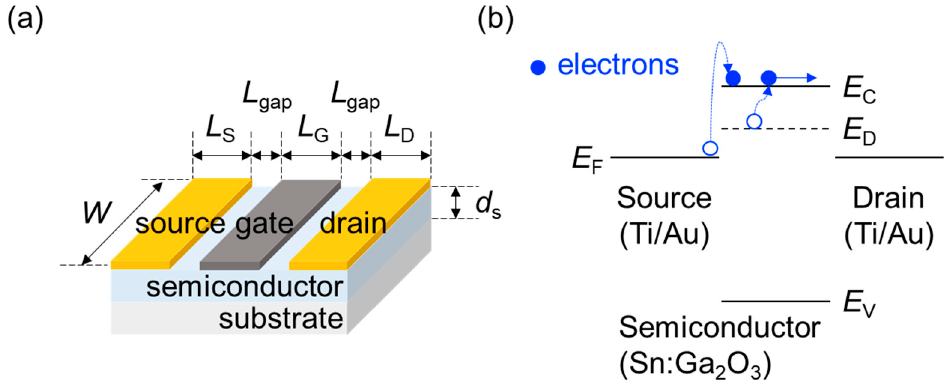
Figure 1. ( a ) A schematic diagram for the device structure of an Sn-doped α -Ga 2 O 3 MESFET; ( b ) the energy diagram of the corresponding device.